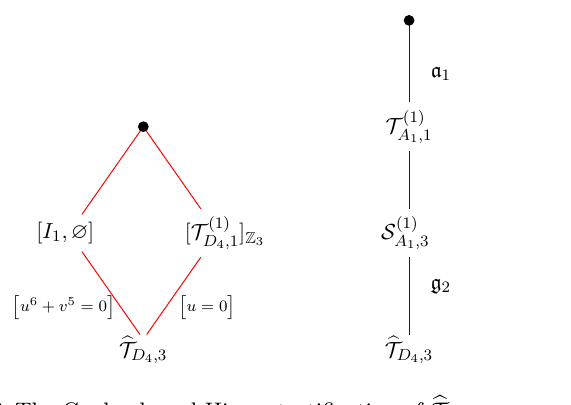
Figure 41. Information about the b T D